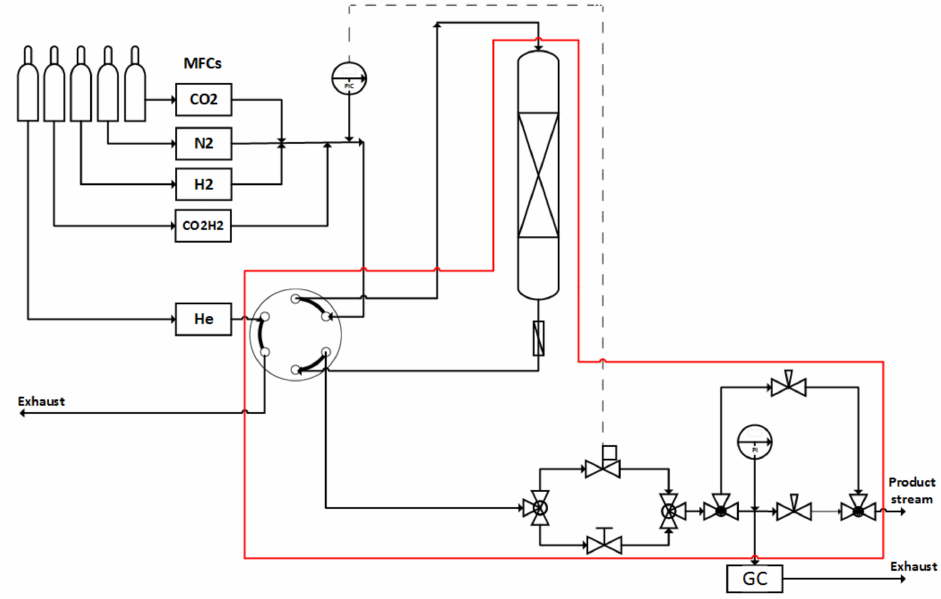
Figure 11. Scheme of the test rig. The set-up is constructed to mount both reactors alternatively. Red line: heated oven box (180 ◦